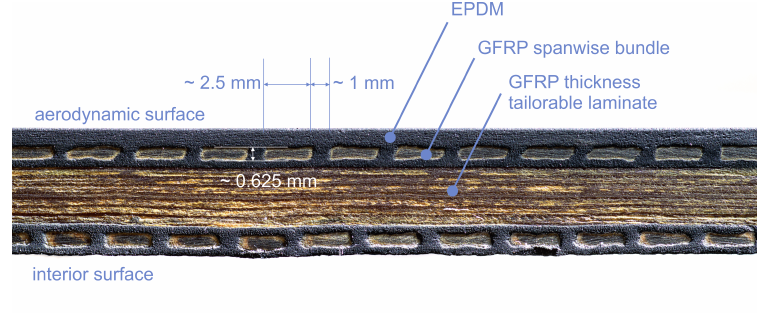
Figure 12. Labelled cross-section-detail photograph of the manufactured